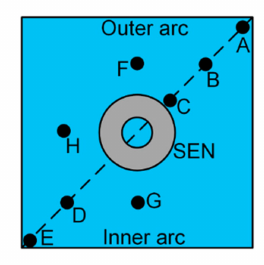
Figure 4. The distribution of measuring points for level fluctuation on top